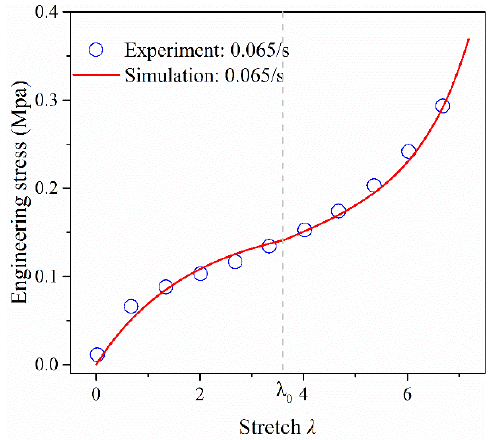
Figure 3. Comparison of the experimental data of soft elastomer at stretch rate 0.065/s and the prediction of the discrete fractional model with variable order.